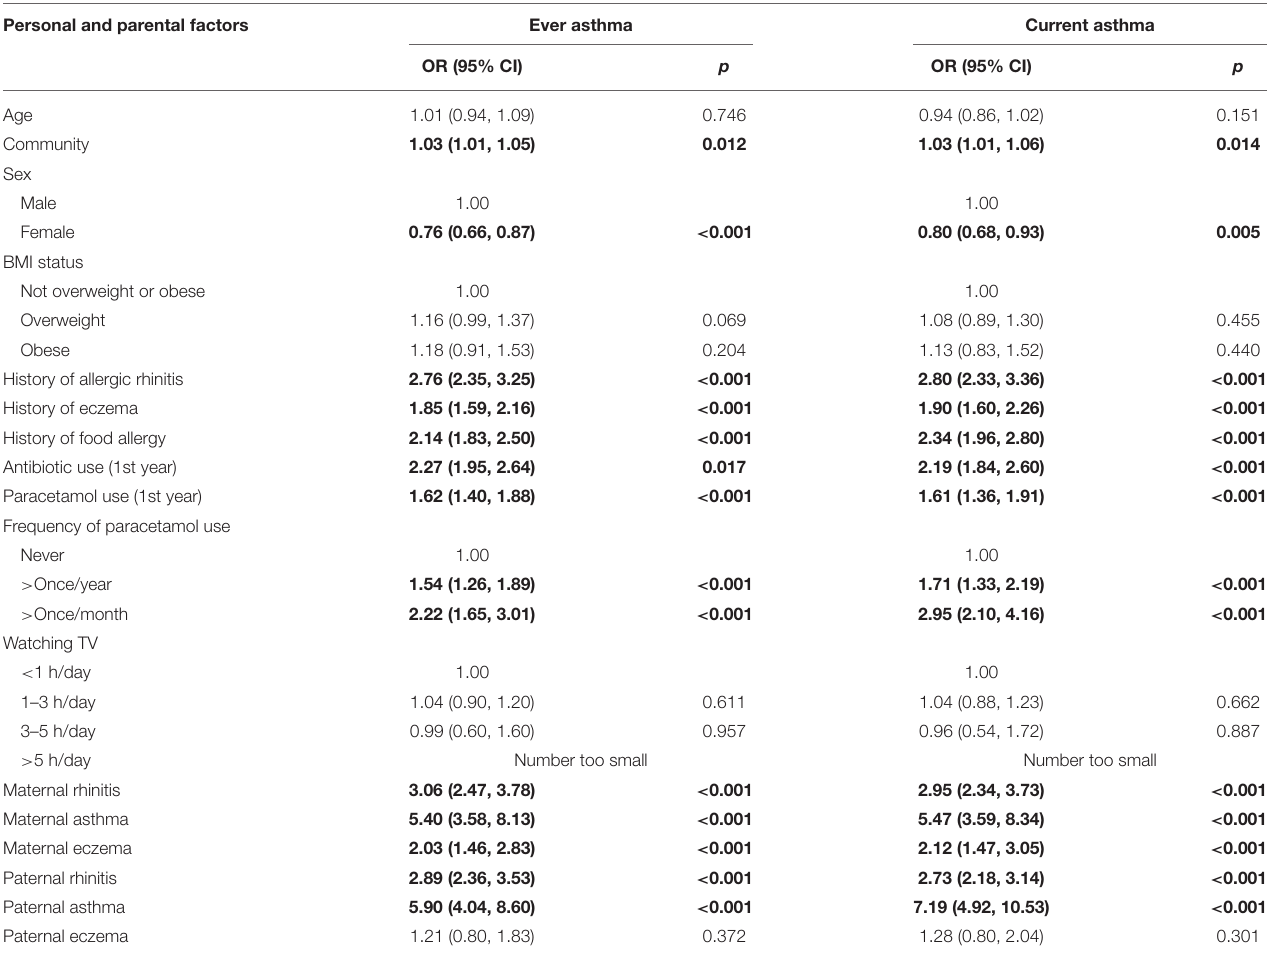
TABLE 2 | Personal and parental factors for asthma symptoms by univariate analyses. Personal and parental